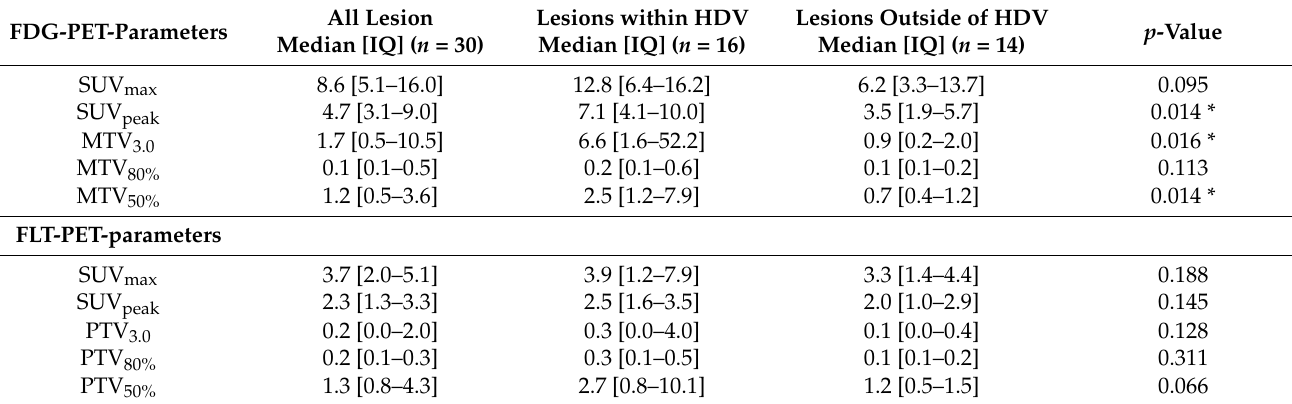
Table 2. PET-parameters in intrapulmonary malignant lesions in patients with relapsed lung cancer. FDG-PET-Parameters